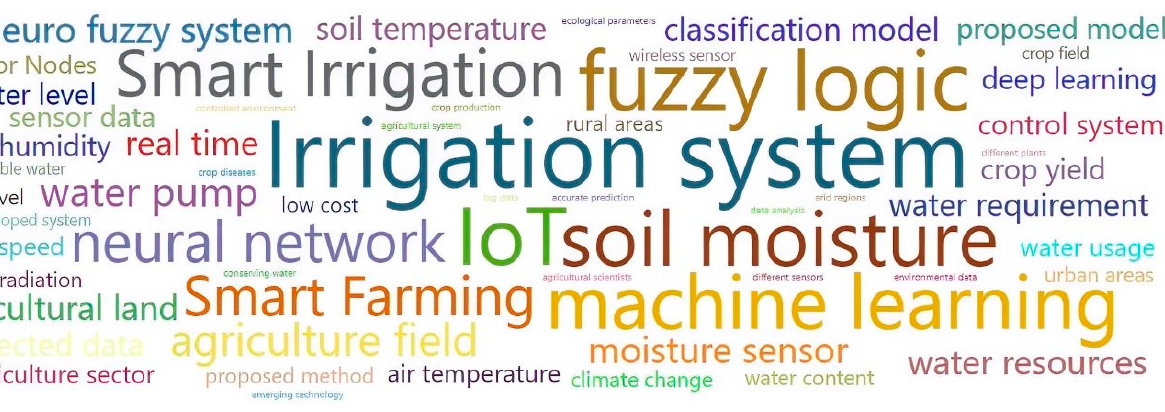
Figure 4. A cloud of sentences. Obtained using VantagePoint.